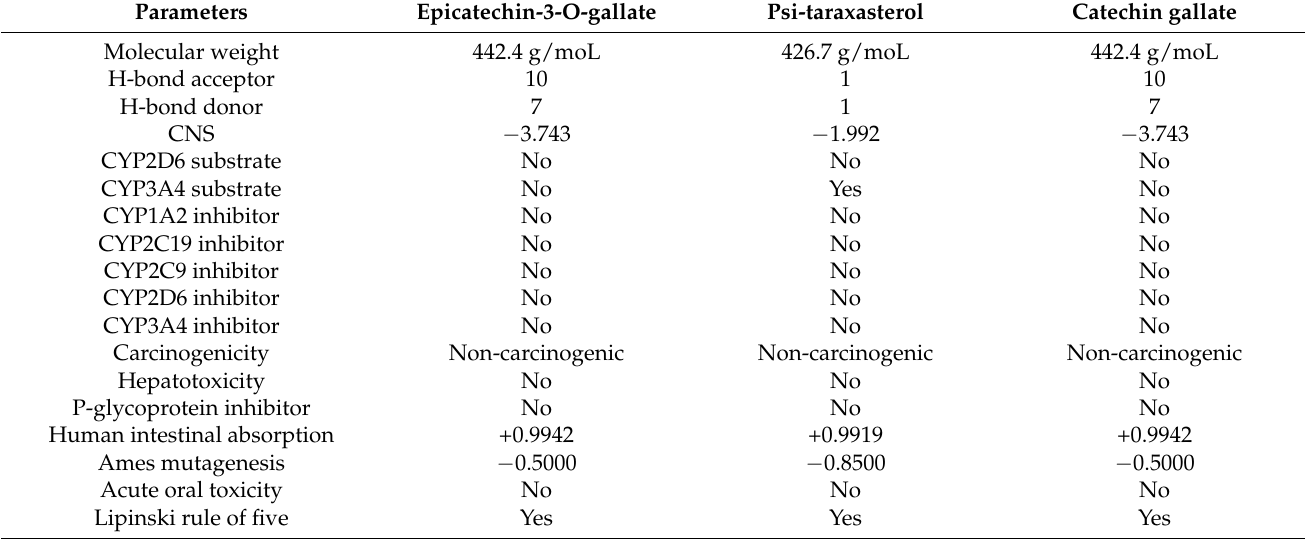
Table 2. Pharmacological profiles for the top three potential candidates, which were derived from the SwissADME, admetSAR, and pKCSM